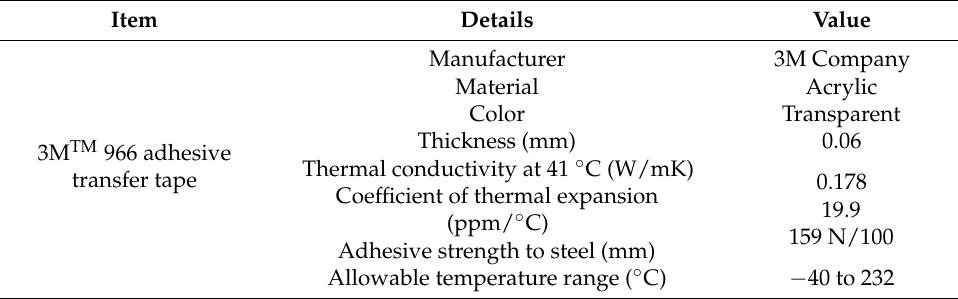
Table 3. Specifications of the double-sided adhesive